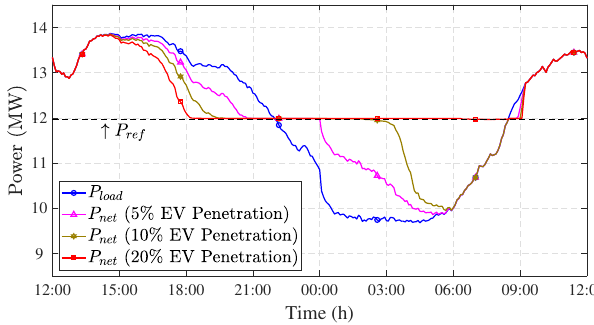
Figure 11. Net load profile of the feeder for various EV penetration